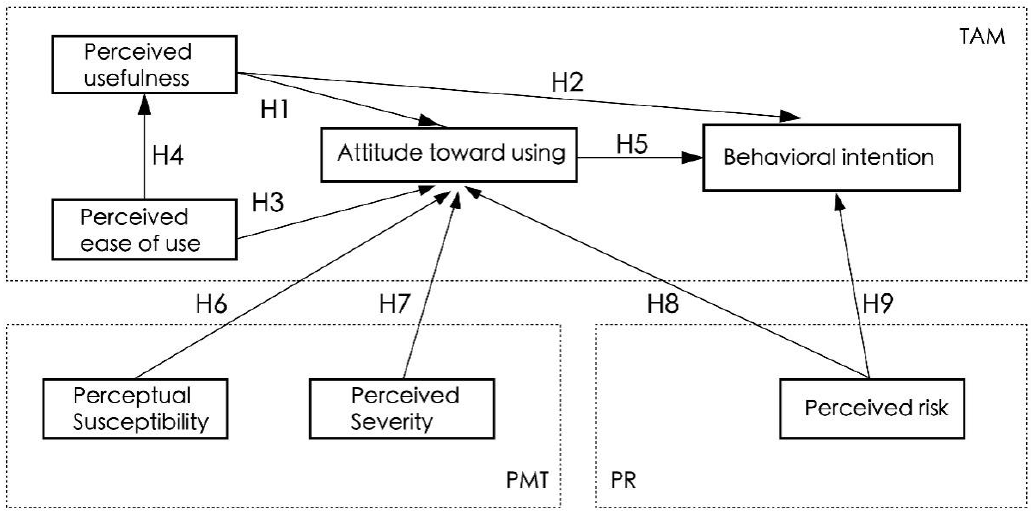
Figure 2. Research model.